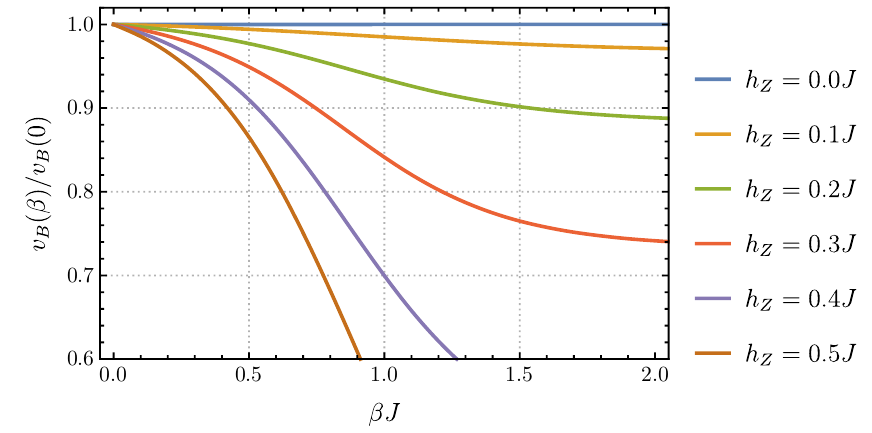
Figure 2: Temperature-dependent butterfly velocity in the mixed field Ising chain = 1.05 J and different h (21) with h . The inverse temperature is denoted as β . X Z = 0 is dual to free fermions and has a temperature-independent The model with h Z butterfly velocity. The appendices contain more details about numerics and error